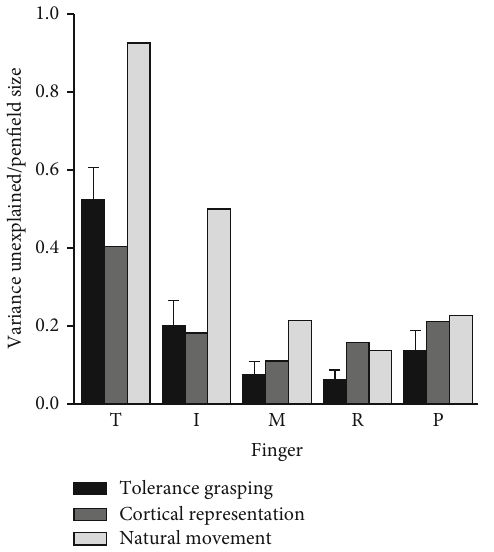
Figure 5: Residual according to Figure 3 results between cortical representation and tolerance grasp and natural movement in unstructured environment.